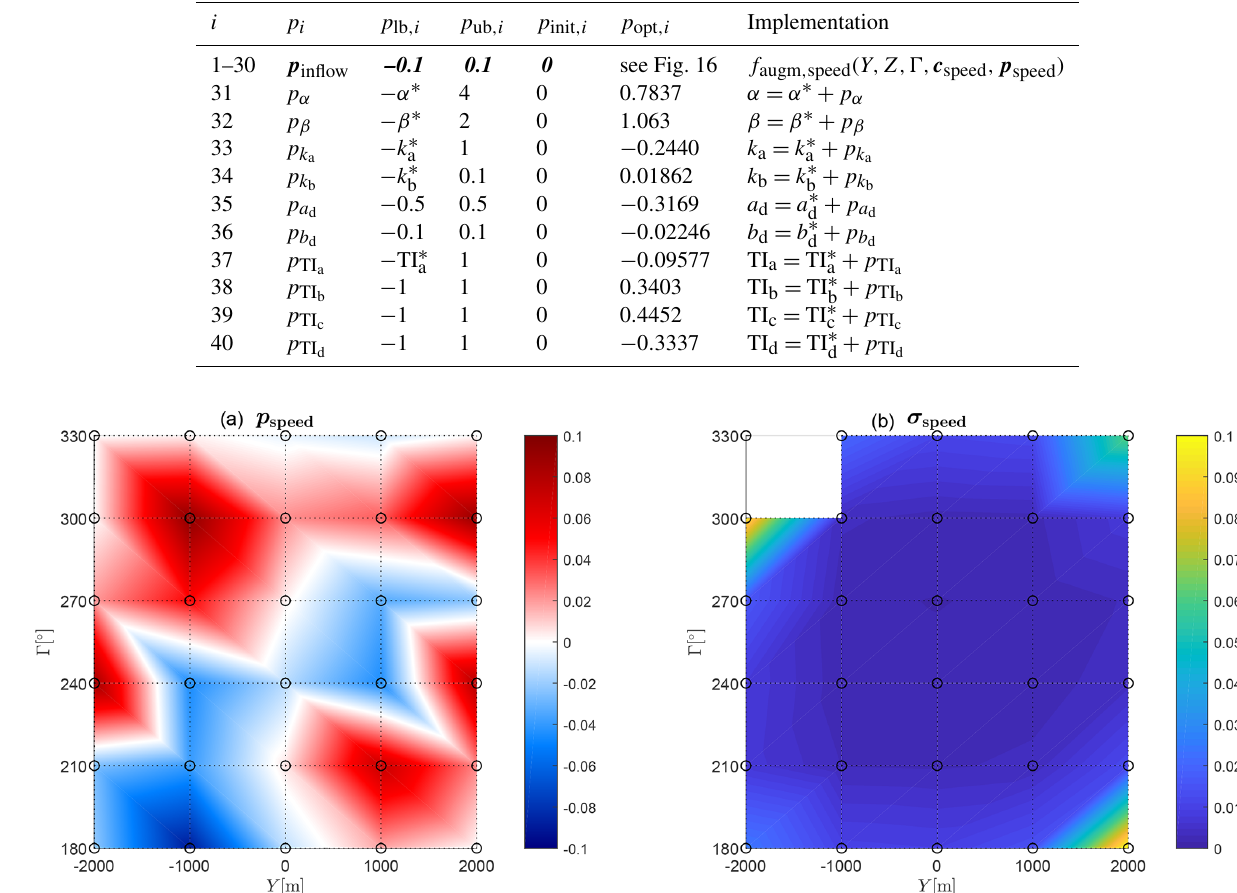
Figure 16. Identified inflow augmentation parameters (a) and their uncertainties (b) . Nodal points are indicated by the circle markers.